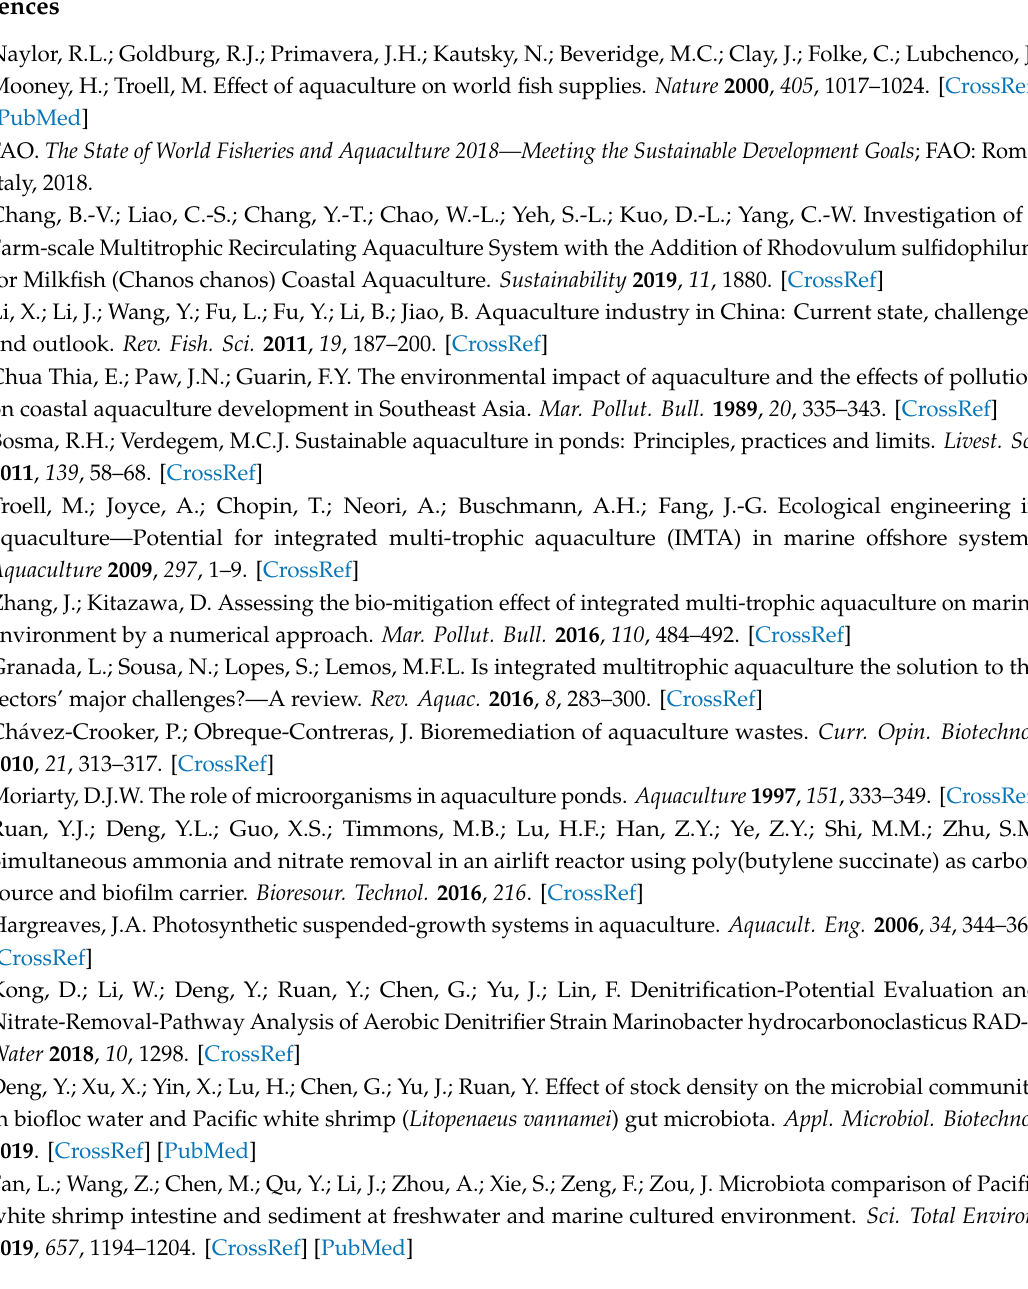
Table S1: The initial stocking density and final harvest biomass of farmed animals, Table S2: The water quality parameters of the combined e ffl uent discharge of two pond systems over weeks, Table S3: Microbial similarity between FFD and FD treatments in water and sediment samples, Table S4: The net income analysis of FFD and FD polyculture ponds in the